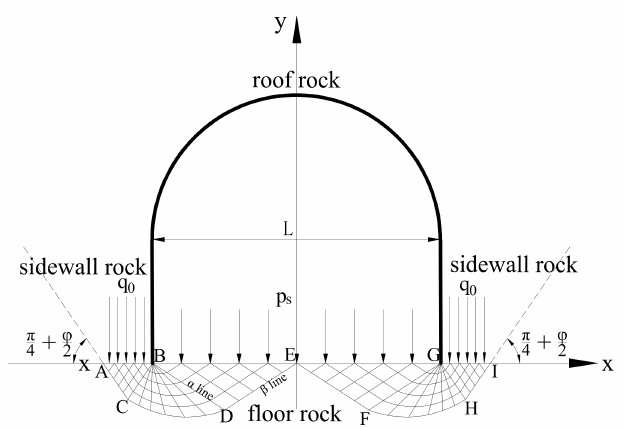
Figure 1. Hill slip line fields of the chamber